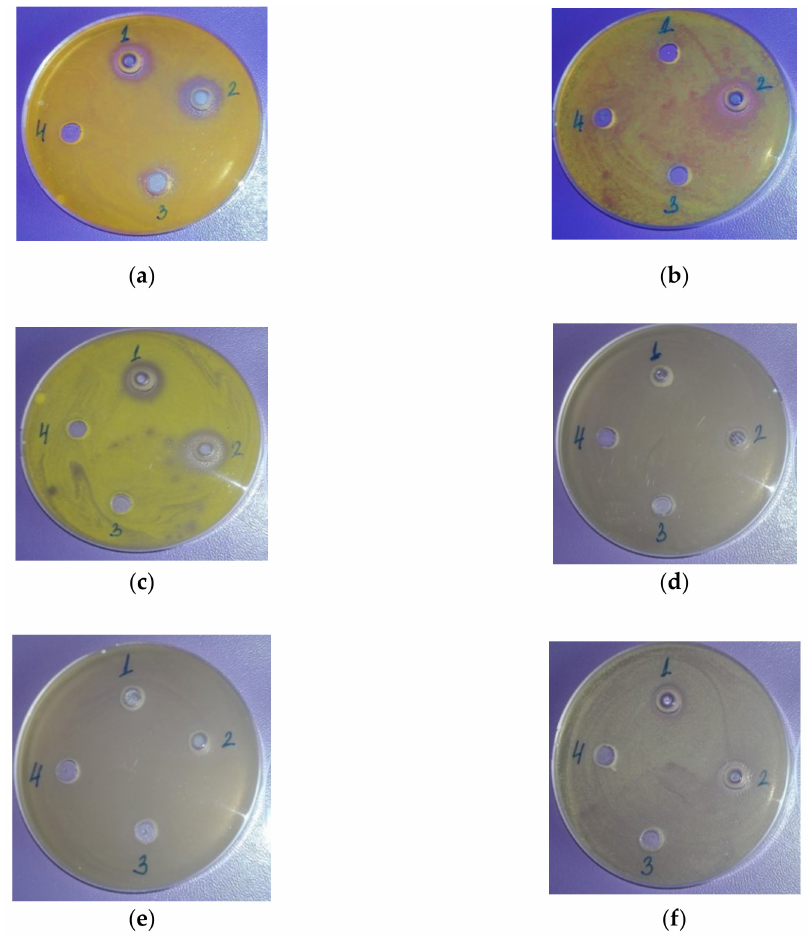
Figure 2. Antimicrobial activity of laurel ( Laurus nobilis L.): (1) fruit EO; (2) leaf EO; (3) twig EO (solution in nonpolar solvent; (4) nonpolar solvent against: ( a ) Staphylococcus aureus ; ( b ) Bacillus subtilis; ( c ) Kocuria rhizophila ; ( d ) Escherichia coli; ( e ) Pseudomonas aeruginosa ; ( f ) Salmonela